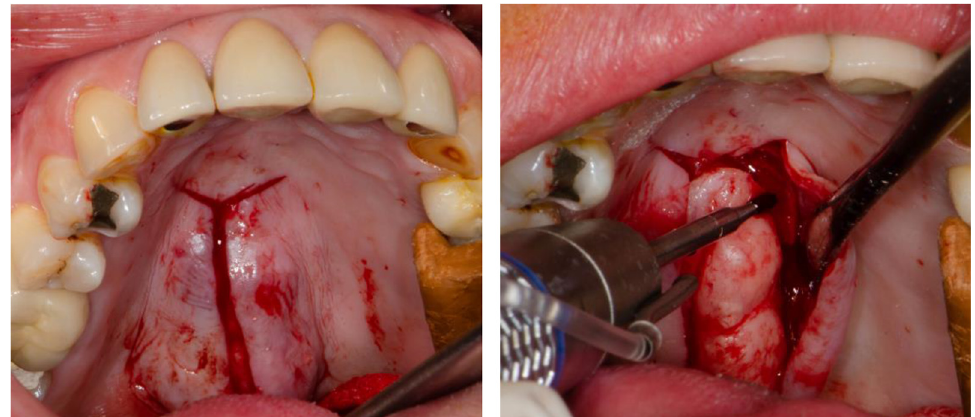
Fig. 3. Bone and mucosal surgical phase (patient T). (a) Double Y cold-knife incision. (b) Initiation of the bone cleavage plane with the fi ssure burr on the